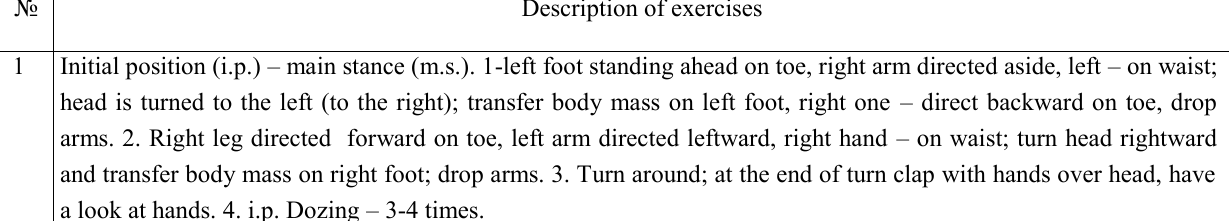
Approximate complex of exercises for coordination of movements for warming up part of training during 1 st and 2 nd months) Description of